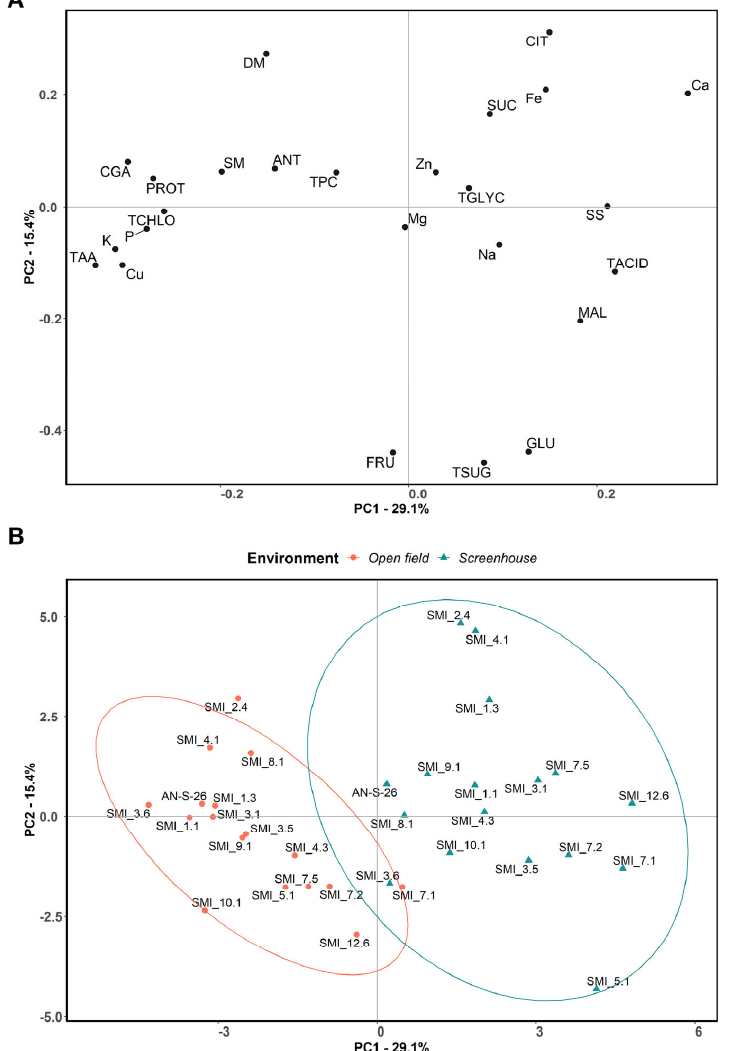
Figure 2. PCA loading plot ( A ) and score plot ( B ) based on the two first principal components for 16 introgression lines with S. incanum (SMI names) and the recipient S. melongena parent (AN-S-26) for 25 composition traits. First and second components account for 29.1% and 15.4% of the total variation, respectively. The accessions are represented by different symbols and colors according to the environment in which they were grown: orange circle for open field, and blue triangle for screen ‐ house. Ellipses grouped the accessions for each treatment with a 95% confidence level. Acronyms used in the loading plot and their meaning are ANT: anthocyanins; TCHLO: total chlorophylls; FRU: fructose; GLU: glucose; SUC: sucrose; TSUG: total sugars; MAL: malic acid; CIT: citric acid; TACID: total acids; PROT: crude protein; TPC: total phenolics; TAA: total antioxidant activity; CGA: chloro ‐ genic acid; SS: solasonine; SM: solamargine; TGLYC: total glycoalkaloids.